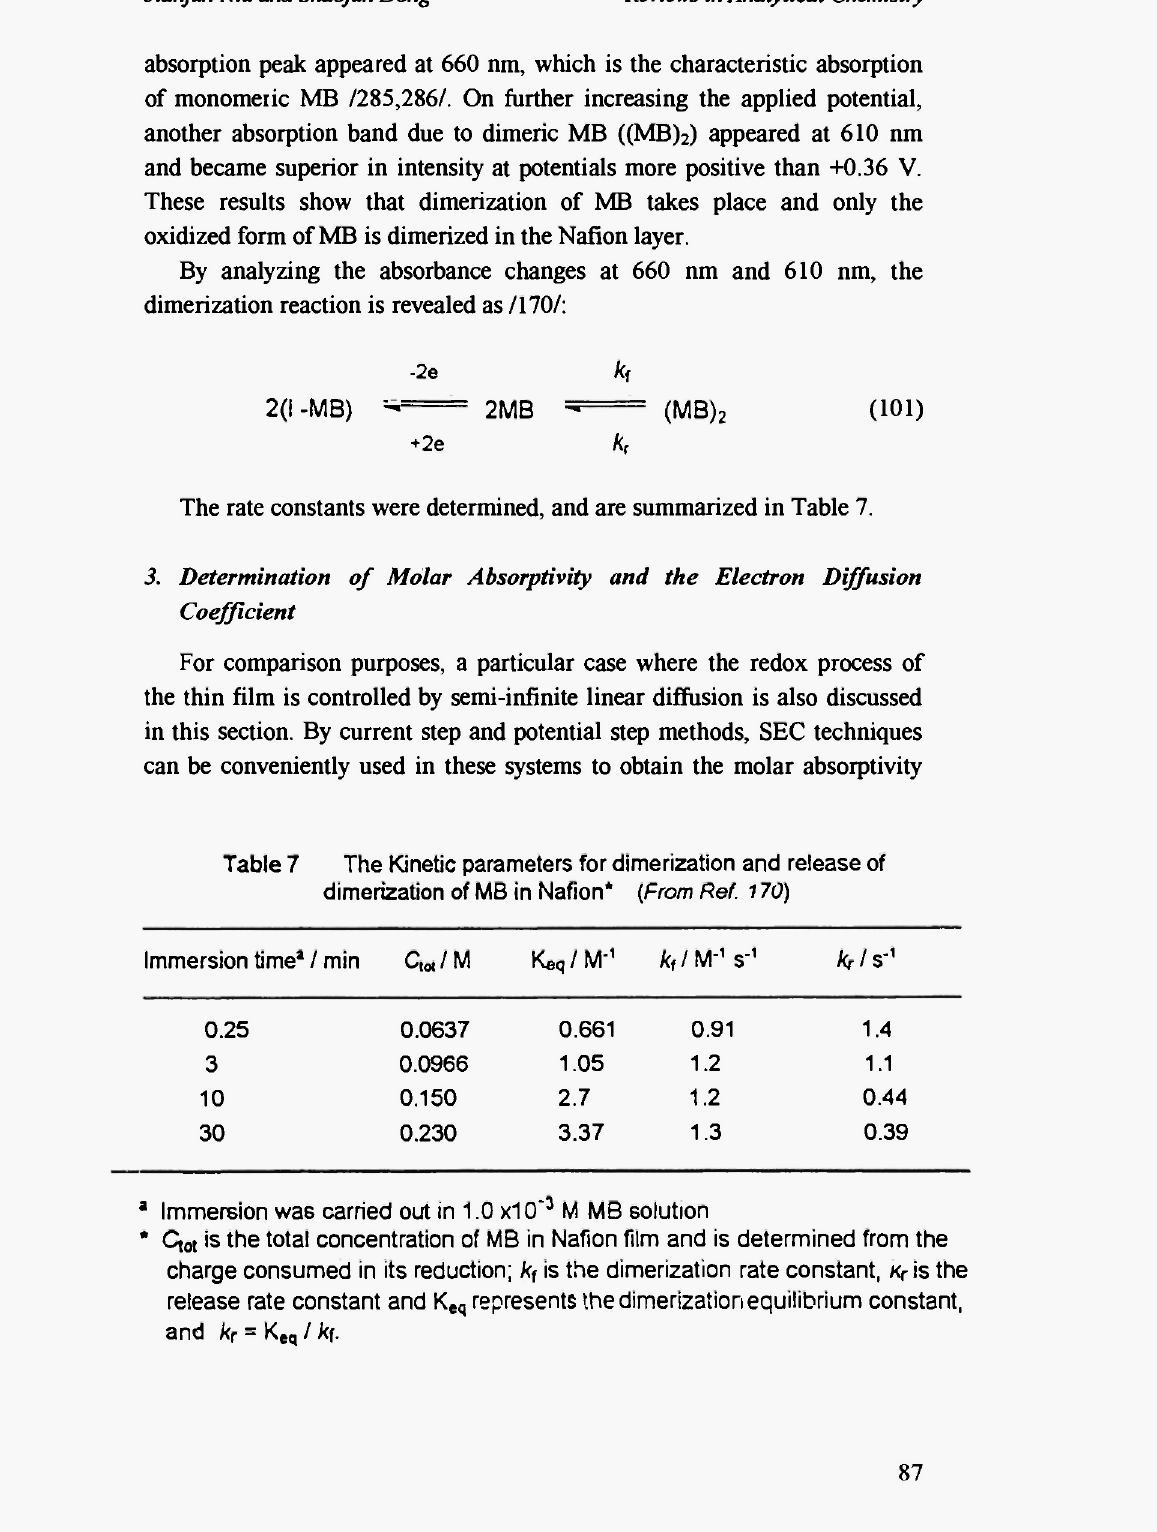
The Kinetic parameters for dimerization and release of dimerization of MB in Nafion* (From Ref.